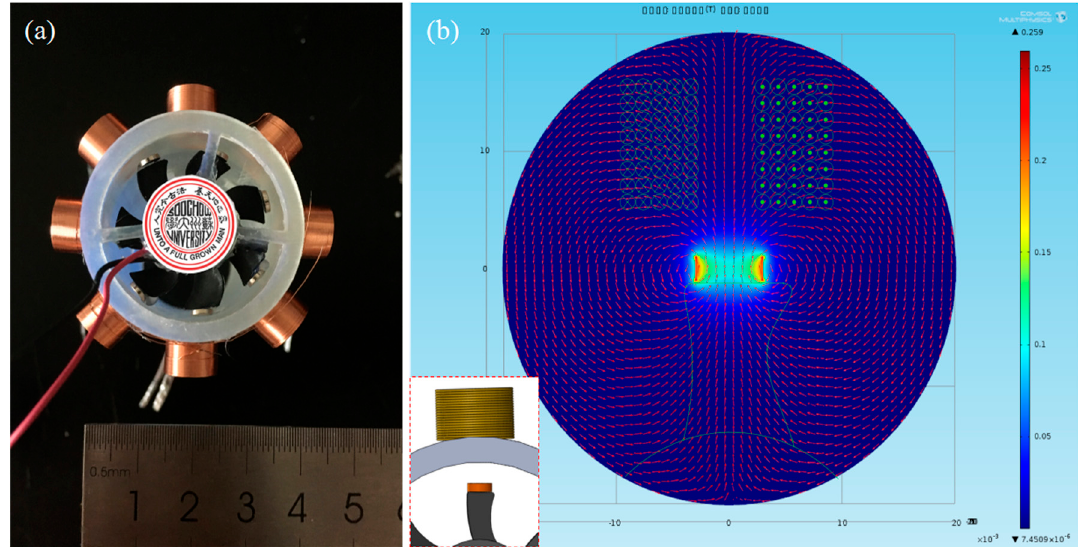
Figure 2. ( a ) Schematic diagram of EMG; and, ( b ) Simulation of the magnetic flux of one magnet across a single coil by COMSOL.